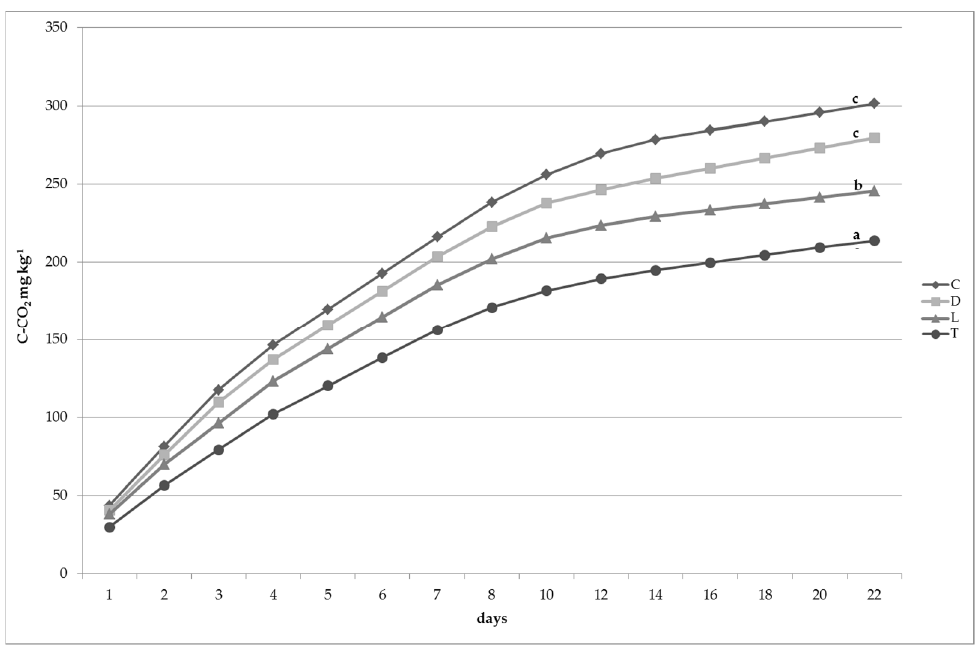
Figure 2. Cumulative CO 2 -C evolution from soil (mg kg − 1 ), values marked with the same letter do not differ significantly at p ≤ 0.05 (LSD test), n = 12.